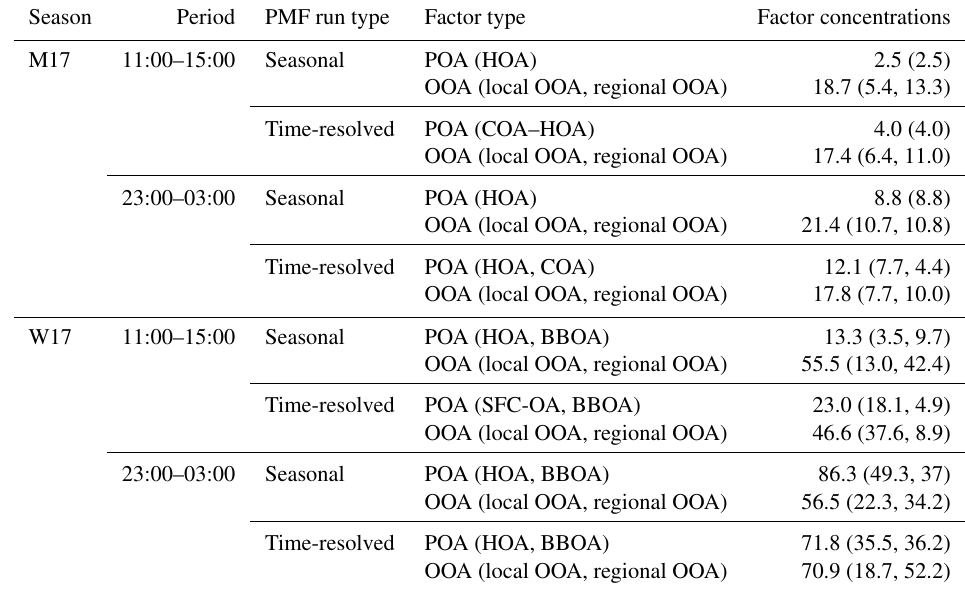
Table 2. PMF factor concentrations in seasonal PMF and time-of-day PMF analysis (in µgm − 3 )